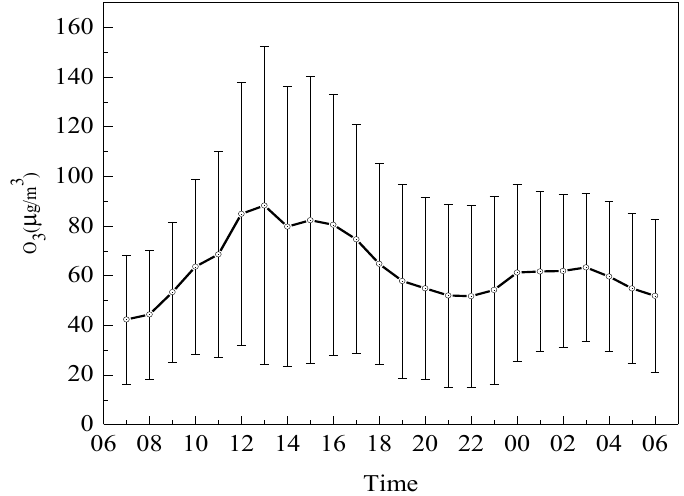
Figure 3. Corresponding daily variation in O 3 concentrations during the occurrence of nighttime O 3 maximums.